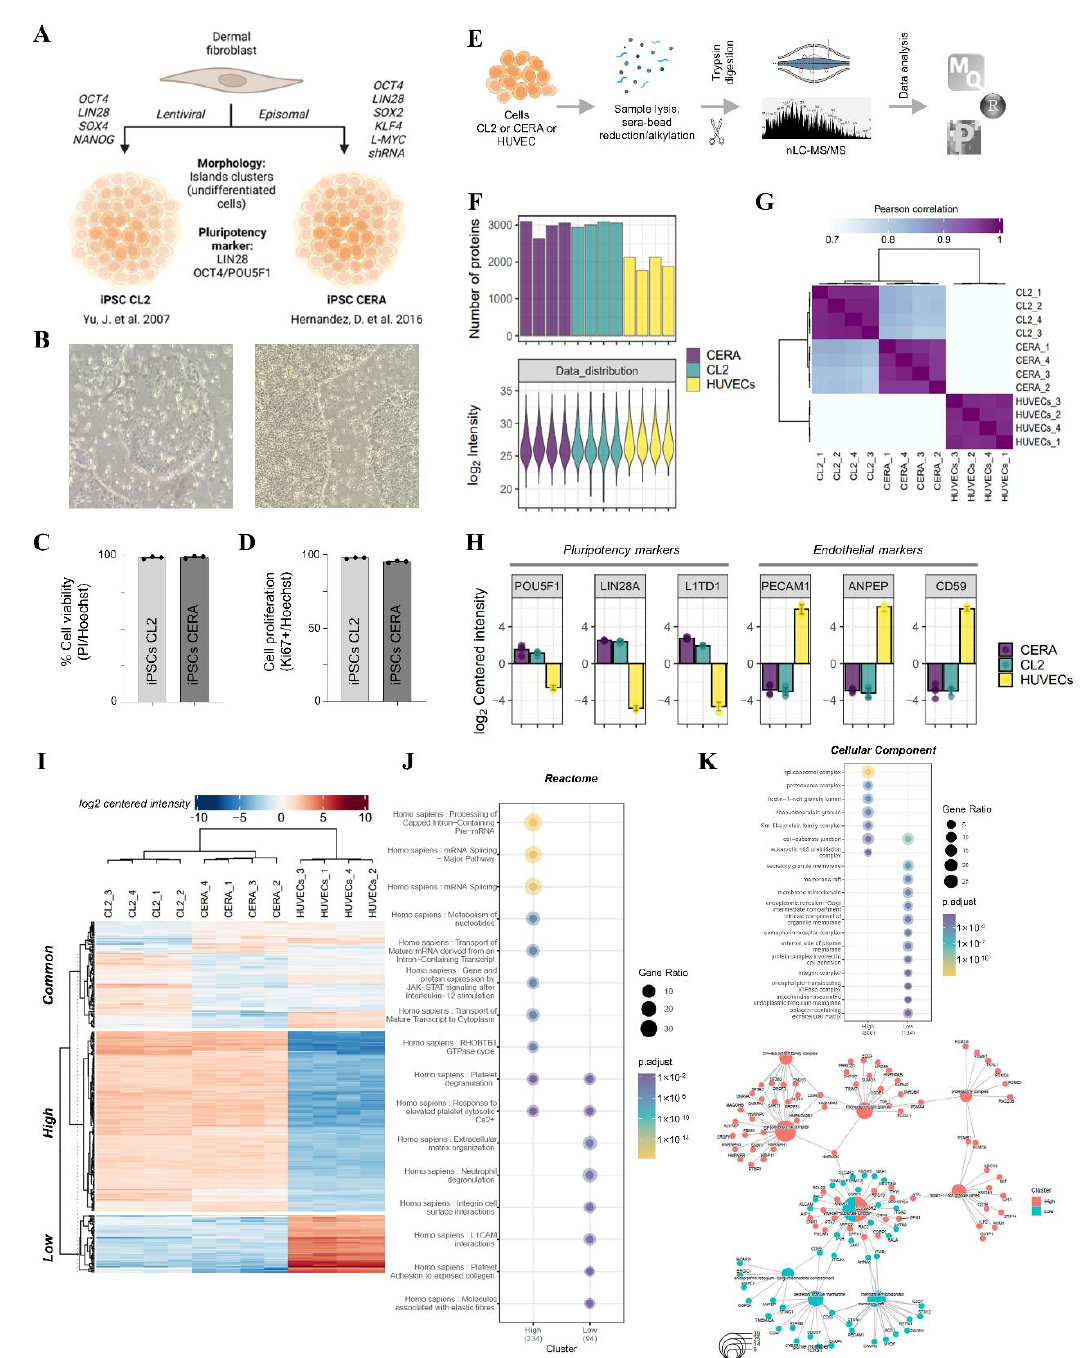
Figure 1. Validation of human-induced pluripotent stem cell lines. ( A ) CL2 and CERA iPSCs are reprogrammed from human dermal fibroblasts using lentiviral and episomal reprograming method, respectively. Pluripotency markers as identified in current study by cell-based proteomic profiling of each iPSC model (CL2/CERA). ( B ) Brightfield microscopy reveals derived iPSCs grow in an island-like pattern (20× magnification). ( C ) iPSC viability as assessed by IP/Hoechst staining ( n = 3). ( D ) iPSC proliferation determined by Ki67 and Hoechst staining ( n = 3). ( E ) Mass spectrom- etry-based proteomic profiling workflow, including sera-bead sample preparation with nano-liquid chromatography tandem mass spectrometry and data processing/informatics. ( F ) Protein identifi- cation and LFQ (normalised) intensity for iPSCs and HUVECs ( n = 4). ( G ) Pearson correlation (R- score) of iPSCs (CL2, CERA) and HUVECs ( n = 4). ( H ) Differential abundance (LFQ centred inten- sity, log2) of pluripotency and endothelial markers as determined by proteomic profiling ( n = 4). ( I )